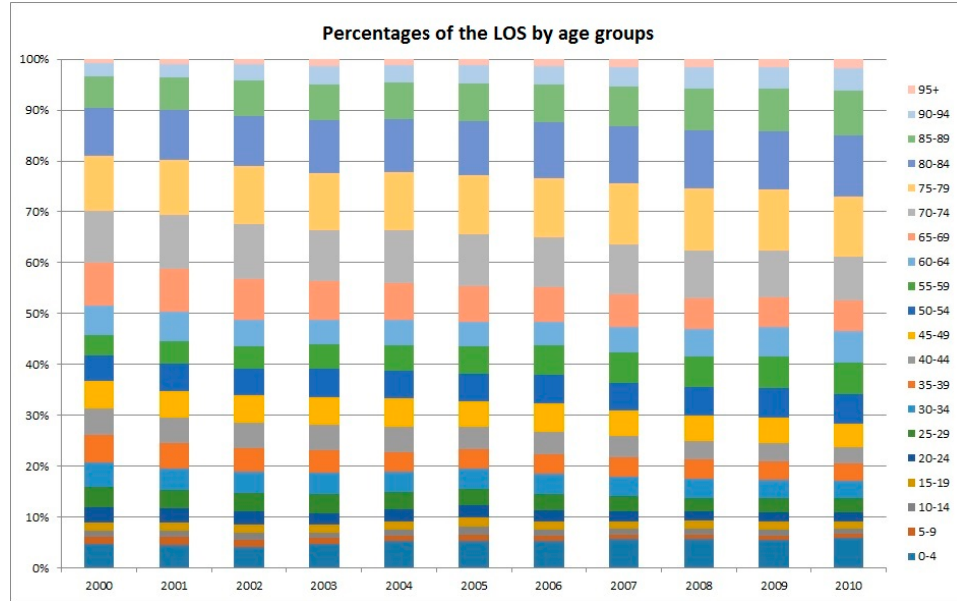
Figure 4. Total length of stay in hospital in each year by age group.